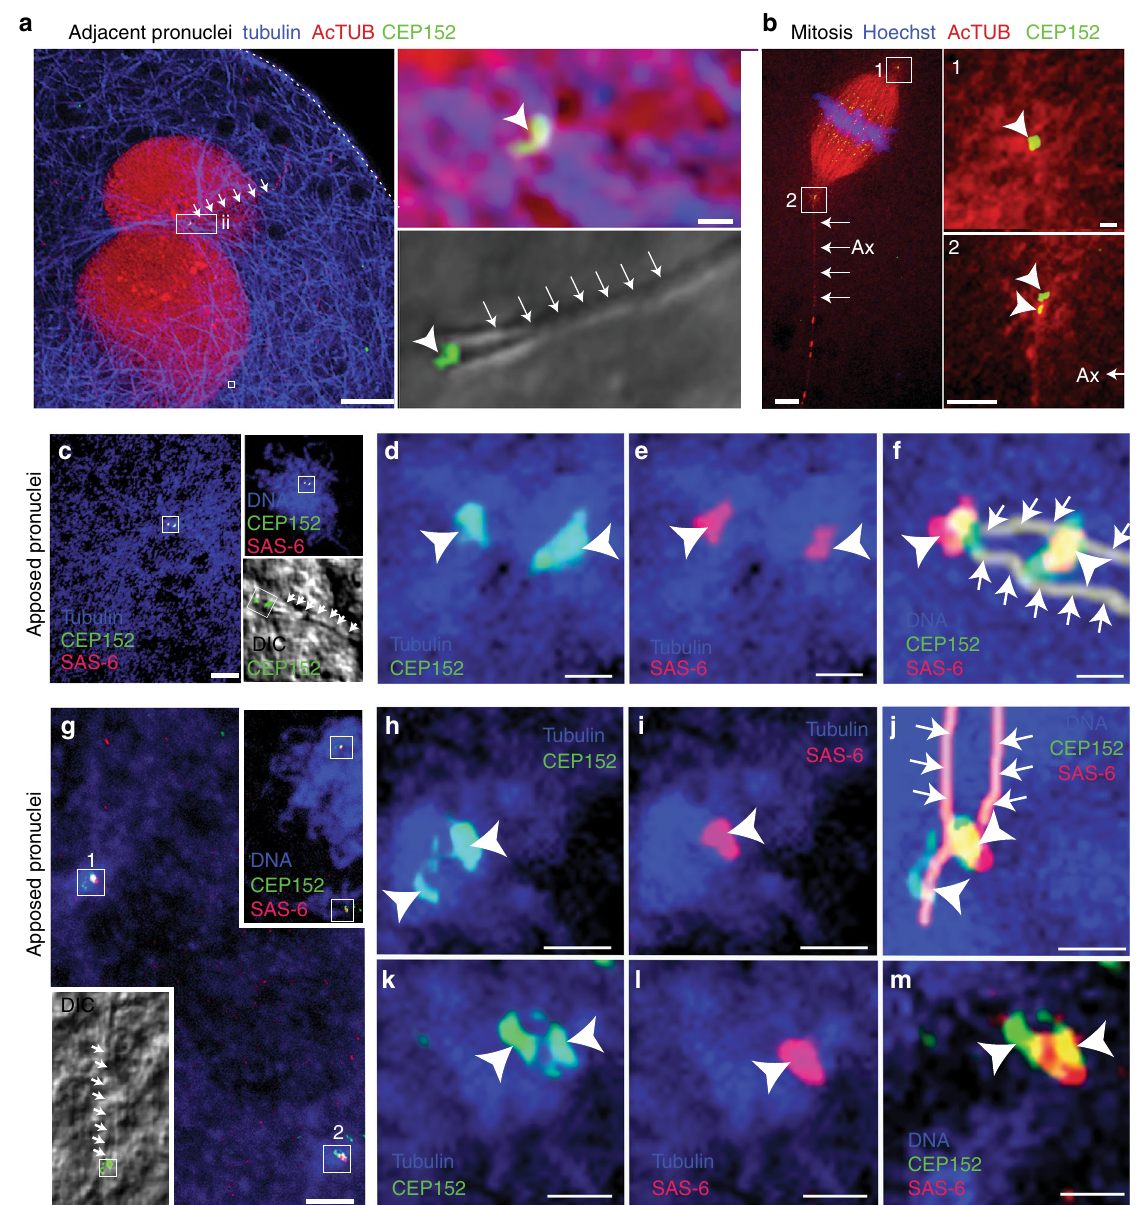
Fig. 6 The remodeled DC is functional in bovine zygotes. a , b The axoneme with a CEP152-labeled DC was observed near the male pronucleus ( a ) and at the spindle poles ( b ). a Adjacent pronuclei (red), and the axoneme (arrows) at low magni fi cation on the left. A pair of CEP152-labeled centrioles (arrowhead, right side high magni fi cation) are found at the axoneme base. The bifurcated axoneme (arrows) is observable using DIC (lower right high magni fi cation). b A spindle (red) with an attached axoneme (red, Ax, arrows) and a pair of CEP152-labeled centrioles (green, arrowheads, pole 2) at one pole and CEP152-labeled centrioles at the other pole (green, arrowhead, pole 1). Centrioles are within an aster (red). Scale bar 10 μ m (left), and 1 μ m (right). c – f Zygote with closely apposed pronuclei with centrioles retained at axoneme base has separated centrioles co-labeled with CEP152 (green) and SAS-6 (red) within a single aster (blue) ( f ). The upper inset in c shows the centrioles relative to the pronuclei (blue). The lower inset in c shows a DIC image of the axoneme (arrows) overlaid with CEP152-labeled centrioles (box, green). The CEP152 (green, arrowheads, d ) and SAS-6-labeled centrioles are within an aster (blue, arrowheads, e ). The composite image ( f ) shows the centrioles (arrowheads) at the bifurcated axoneme base (arrows). Scale bar 10 μ m (left), and 1 μ m (right). g – m A zygote with two separated centriole pairs (box “ 1 ” and “ 2 ” in g that each reside in an aster; blue). Upper inset in g , shows DNA (blue), and the labeled centrioles (boxes) relative to the pronucleus (blue). Lower inset in g shows a DIC image of the bifurcated axoneme (arrows) and CEP152-labeled centriole pair 1 (box). h – j Enlarged images of centriole pair 1 showing details of CEP152 (green, arrowheads, h ) and SAS-6 (red, arrowheads, j ) within the aster (blue). Image j shows centriole pair 1 (arrowheads) at the bifurcated axoneme base (arrows). k – m Enlarged images of centriole pair 2 showing CEP152 (green, arrowhead, k ) and SAS-6 (red, arrowheads, l ) within the aster (blue). Image ( m ) shows centriole pair 2 (arrowheads). Scale bar 10 μ m (left), and 1 μ m